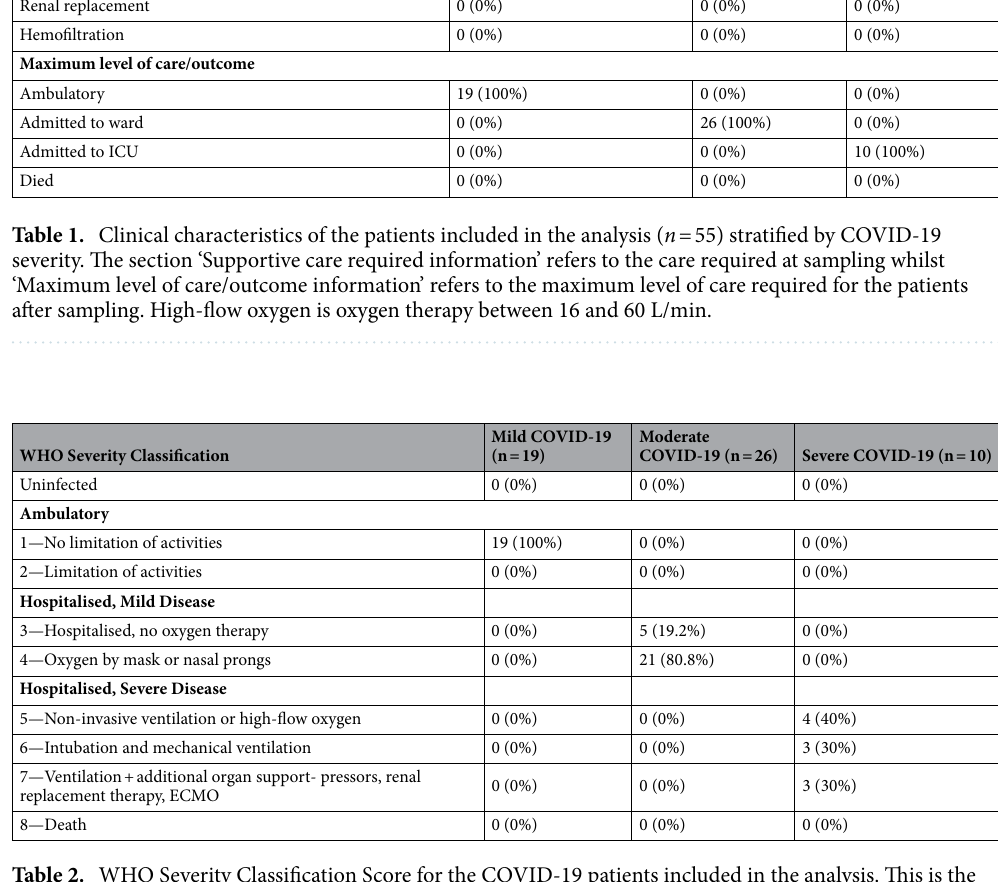
Table 2. WHO Severity Classification Score for the COVID-19 patients included in the analysis. This is the patients’ final severity score rather than their severity at the time of sampling (as shown in Table 1).